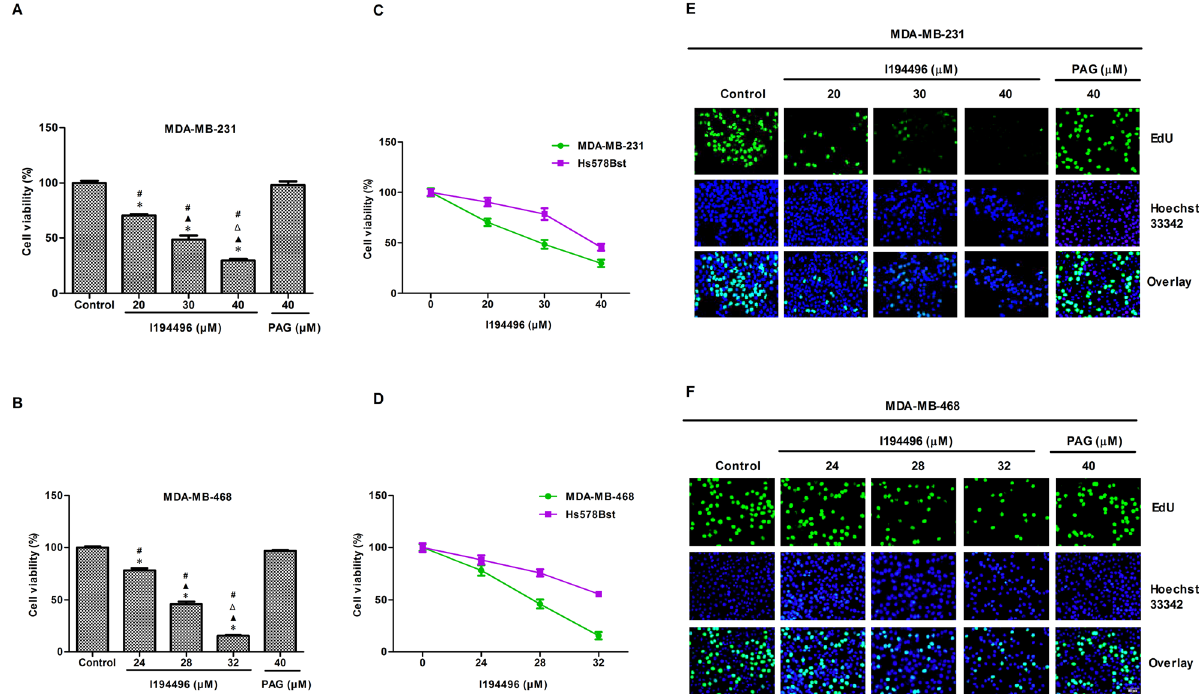
group. Δ P < 0.05 vs 30 μM I194496 group. # P < 0.05 vs PAG group. ( B ) MTS assay was used to detect the